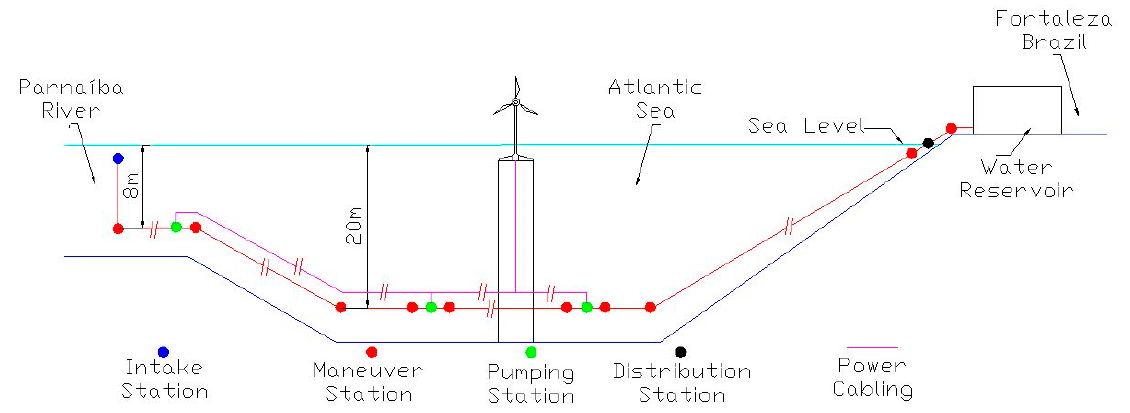
Figure 8. Schematic diagram of the underwater pipeline to Fortaleza, Brazil.